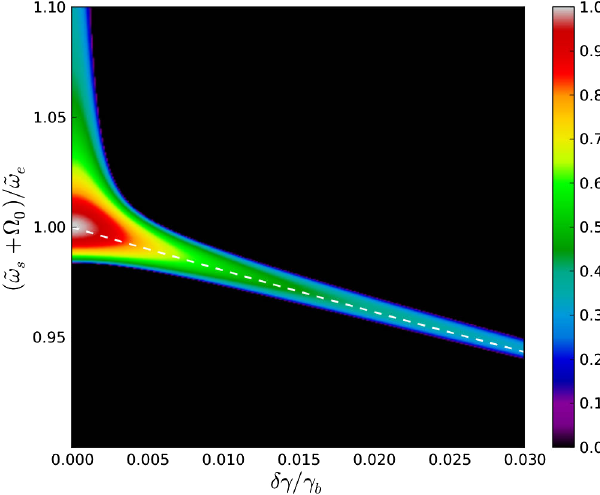
FIG. 3. Normalized FEL parameter ρ = ρ 0 as a function of longitudinal temperature and signal frequency given by Eq. (18). The white dashed line corresponds to the resonance condition Eq.